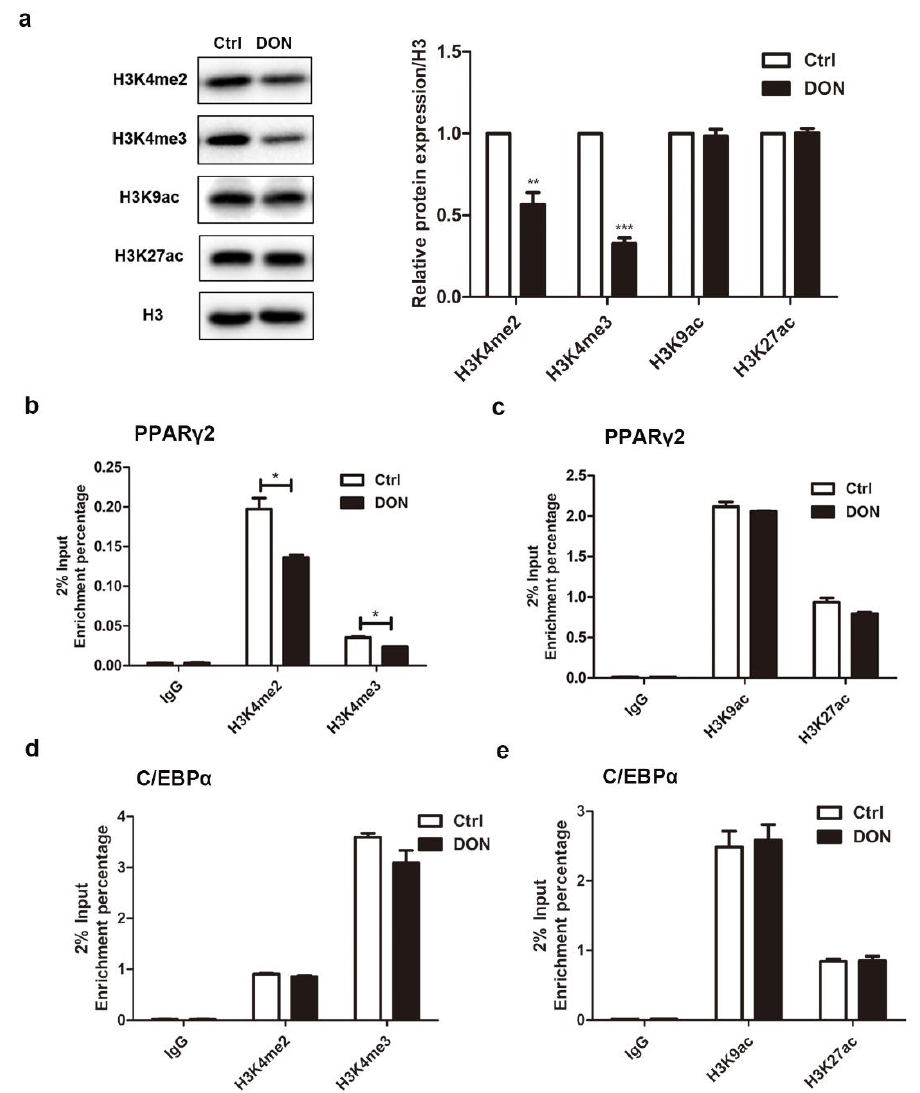
Figure 7. DON regulated the expression of PPARγ2 through H3K4me2 and H3K4me3. ( a ) 3T3-L1 cells were differentiated and treated with or without DON (100 ng/mL) for 7 days. The expression of H3K4me2, H3K4me3, H3K9ac, and H3K27ac was quantified by Western blotting in 3T3-L1 cells (left). Quantification of protein levels (right). ( b ) The 3T3-L1 cells were differentiated and treated with or without DON (100 ng/mL) for 7 days. The cells were prepared for ChIP assays using the indicated antibodies. The binding occupancy was monitored by qPCR using primer sets for the targeted promoter. ChIP assays of H3K4me2 and H3K4me3 on Pparγ2 promoter. ( c ) ChIP assays of H3K9ac and H3K27ac on Pparγ2 promoters. ( d ) ChIP assays of H3K4me2 and H3K4me3 on C/ebpα promoters. ( e ) ChIP assays of H3K9ac and H3K27ac on C/ebpα promoters. The data are expressed as the fold enrichment relative to that of IgG normalized to that of a nonbinding region. The results are representative of three independent experiments, and statistical significance is indicated by * p < 0.05, ** p < 0.01, *** p < 0.001.